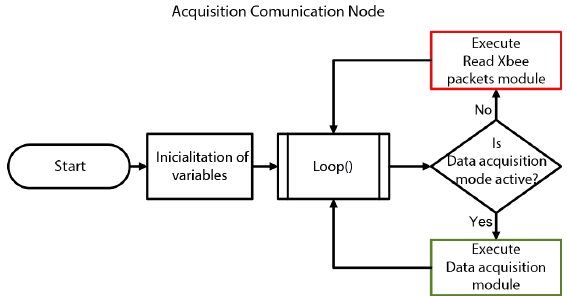
Figure 9. General flowchart of the ACN software.